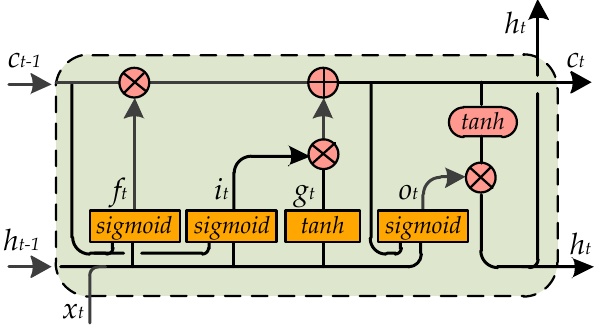
Figure 2. The internal structure of ConvLSTM.